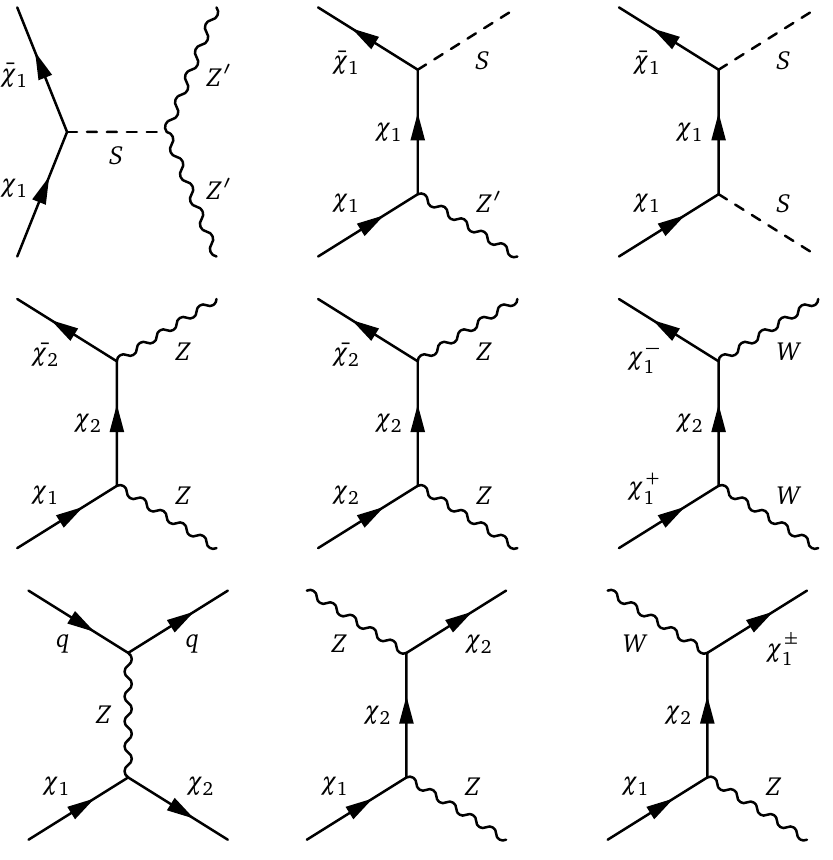
¯ χ Figure 4: Top row: new diagrams for χ annihilation involving S absent in a Sim- 1 1 plified Model where the Z (cid:48) gets its mass using the Stückelberg mechanism. Middle row: example diagrams which contribute to the co-annihilation cross section into weak bosons. Bottom row: example diagrams which allow the conversion processes χ ψ → χ ψ ans χ ψ → χ ± ψ (where ψ is any Standard Model particle) to occur, 1 2 1 1 which are suppressed by one factor of the singlet-doublet mixing. The first process on this row strongly dominates the interconversion rates in the dark sector due to the low quark